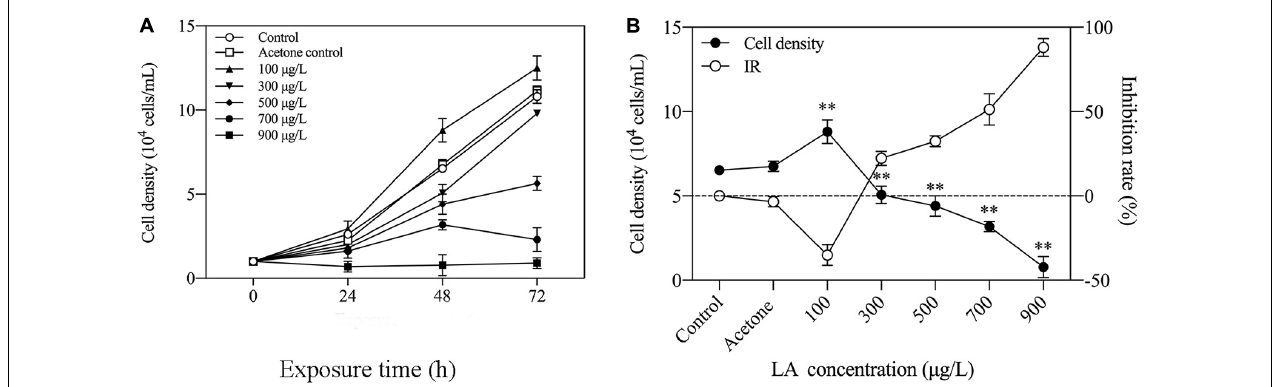
FIGURE 1 | Changes in population growth in H. akashiwo exposed to LA. (A) Growth curves of H. akashiwo exposed to different concentrations of LA for 72 h. (B) Inhibition rate of H. akashiwo exposed to different concentrations of LA after 48 h of exposure. The data are presented as the mean ± SD ( n = 3). Asterisks indicate significant differences from acetone control ( ∗∗ indicate p < 0.01).